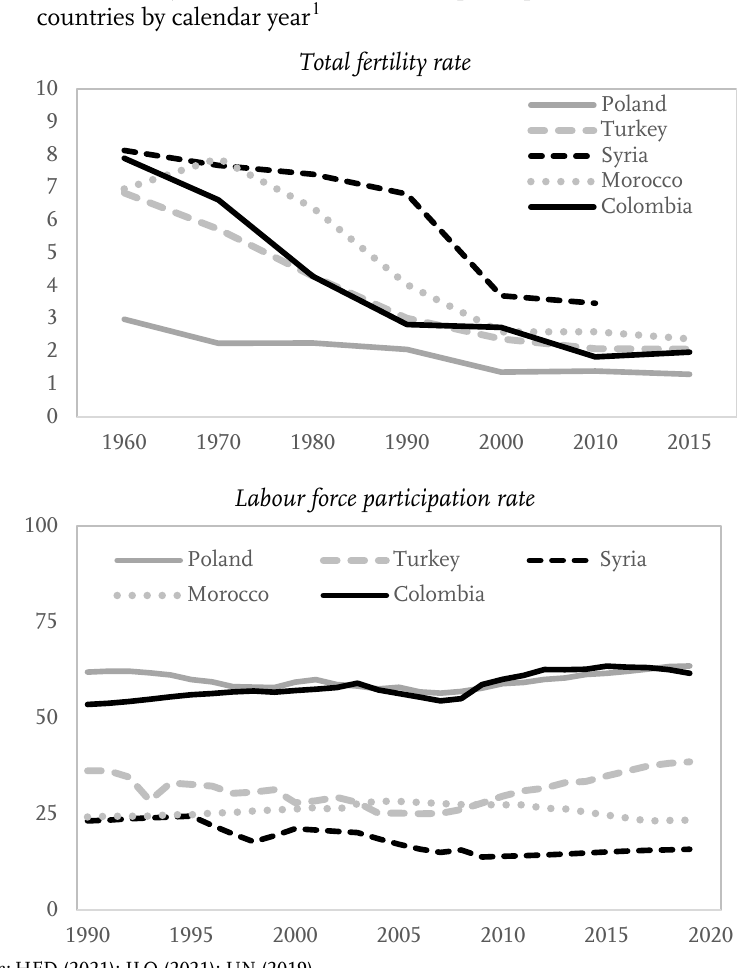
Figure 3 : Total fertility rate and labour force participation rate in selected origin countries by calendar year 1 Total fertility rate